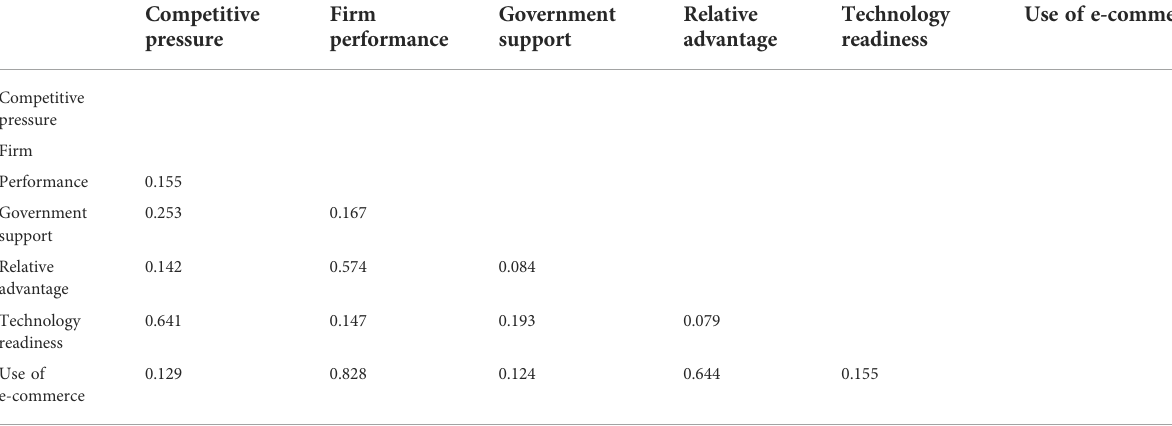
TABLE 6 Heterotrait – Monotrait ratio of correlation